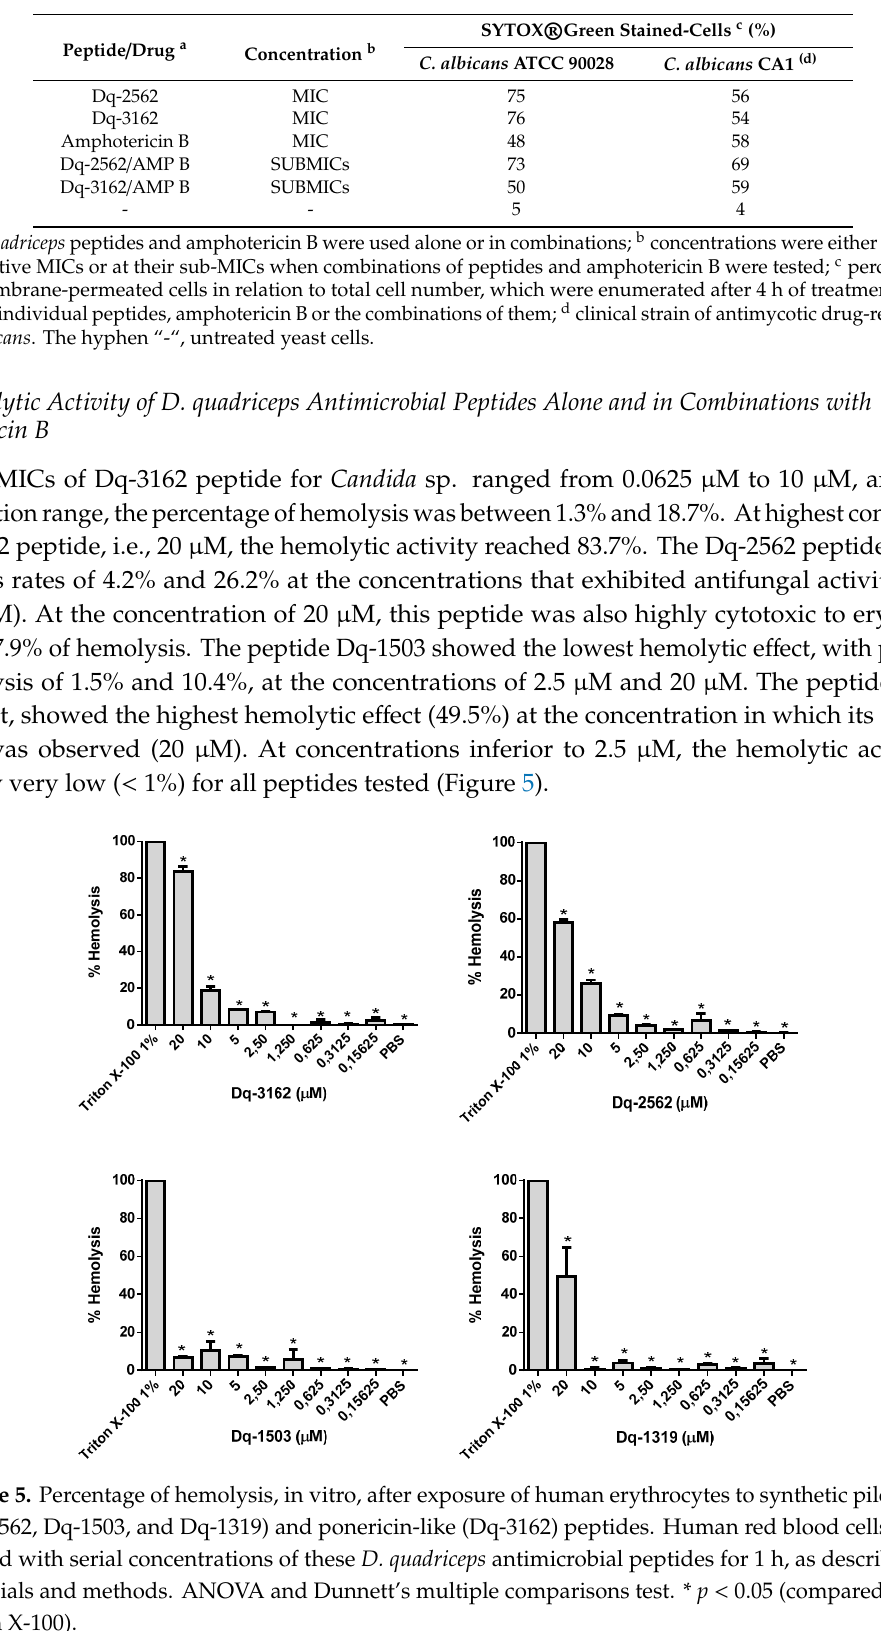
Table 4. Accumulation of SYTOX ® Green in Candida cells with disrupted membranes induced by pilosulin- (Dq-2562), ponericin-like (Dq-3162) peptides and peptide combinations with amphotericin B. SYTOX ® Green Stained-Cells c (%) Peptide / Drug a Concentration b C. albicans ATCC 90028